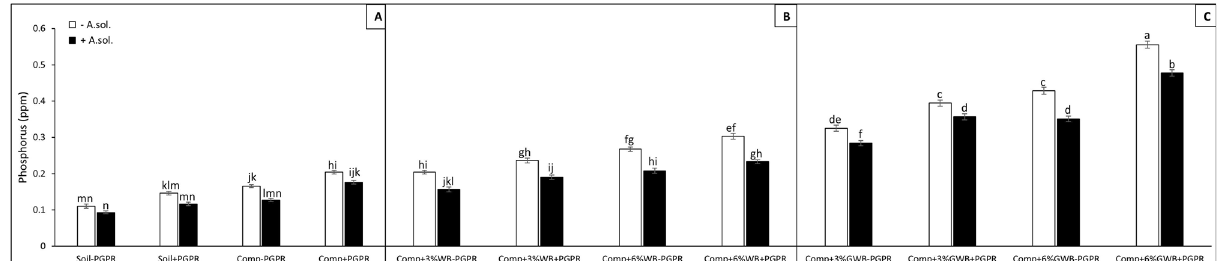
Figure 5. Effect of Alternaria solani and PGPR on phosphorus contents of leaf tissues in leaf tissues of tomato raised in various soil substrate compositions including; ( A ) soil and compost (Comp) alone with (+ PGPR) and without PGPR (− PGPR), inoculated (+ A. solani ) or un-inoculated (− A. solani ), ( B ) compost (Comp) with 3 and 6% wood biochar (WB) with (+ PGPR) and without PGPR (− PGPR), inoculated (+ A. solani ) or un-inoculated (− A. solani ), ( C ) compost (Comp) with 3 and 6% Green waste biochar (GWB) with (+ PGPR) and without PGPR (− PGPR), inoculated (+ A. solani ) or un-inoculated (− A. solani ). All values represent mean ± SE, recorded 40 days after transplantation. Bars with different letters on the top suggest significant difference as per Tukey’s HSD test ( P ≤ 0.05).